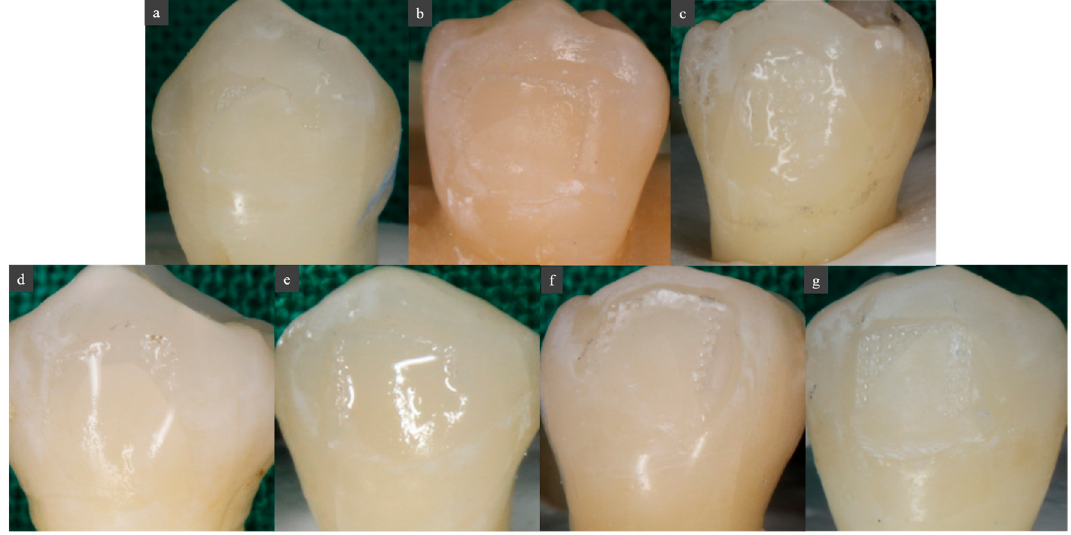
Figure 4. Images of tooth surface after shear bond strength test. ( a ) Control; ( b ) BAG 0.2%; ( c ) BAG 1.0%; ( d ) BAG@Ag1 0.2%; ( e ) BAG@Ag1 1.0%; ( f ) BAG@Zn5 0.2%; ( g ) BAG@Zn5 1.0%.